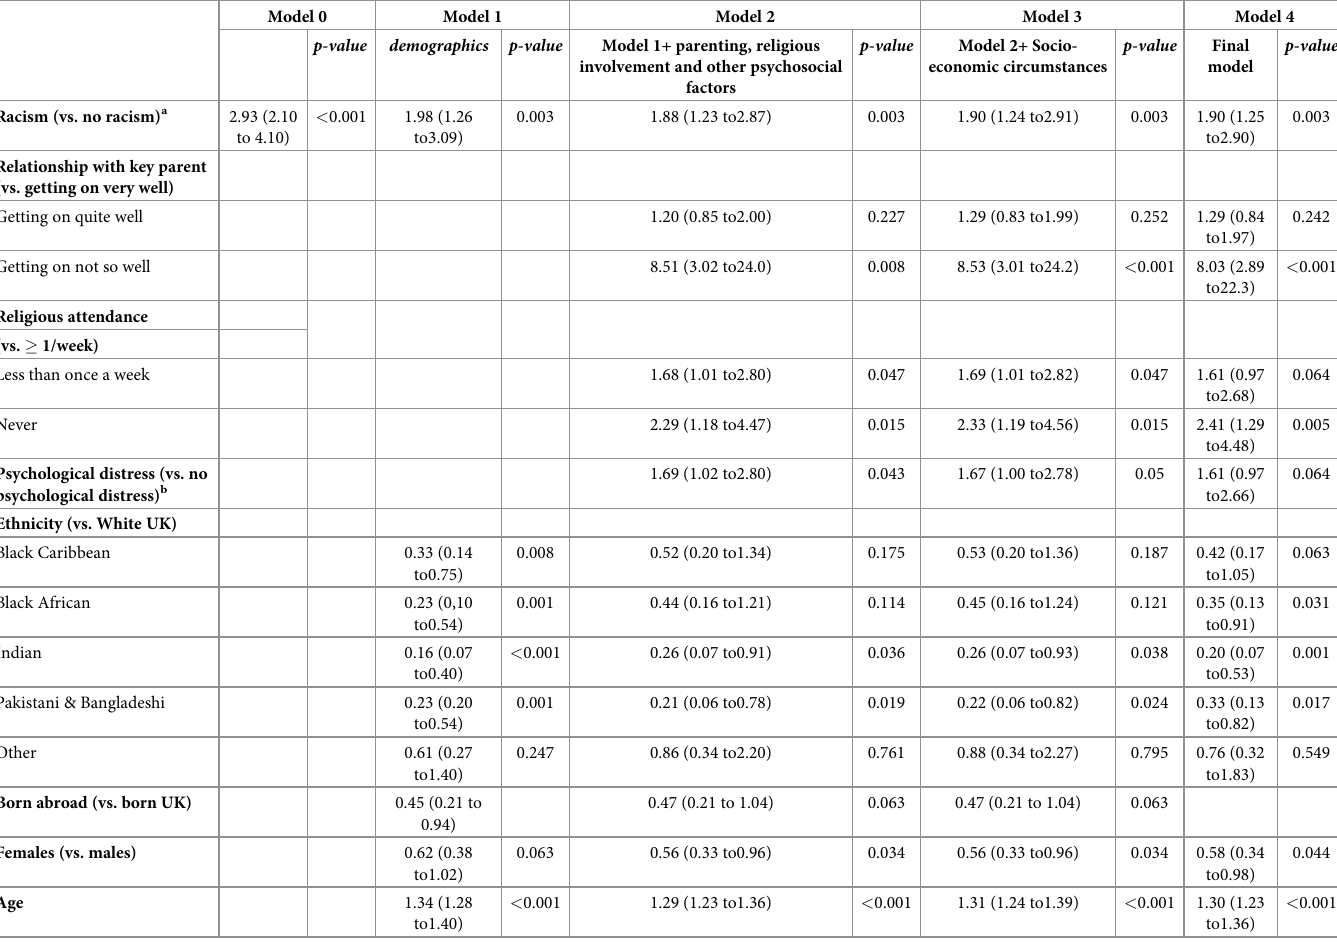
Table 6. Ever smoking at 11-23y: The influence of racism, ethnicity, parenting and religious involvement, socio-economic circumstances: Odds ratio (95% confi- dence interval). The Determinants of Adolescent (now adult) Social well-being and Health 10% (N = 665) pilot follow-up